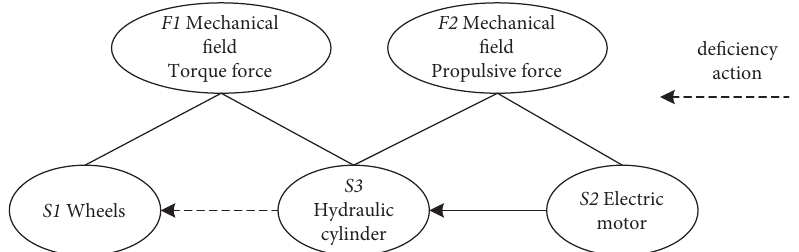
Figure 6: The substance-field model including hydraulic cylinder.